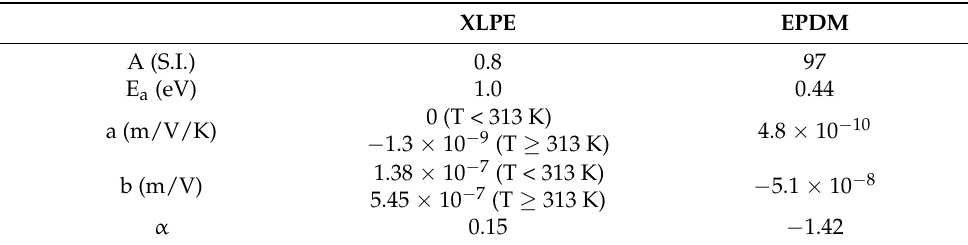
Table 1. Parameters of the conductivity equation used for crosslinked polyethylene (XLPE) and ethylene-propylene-diene monomer terpolymer (EPDM) materials.